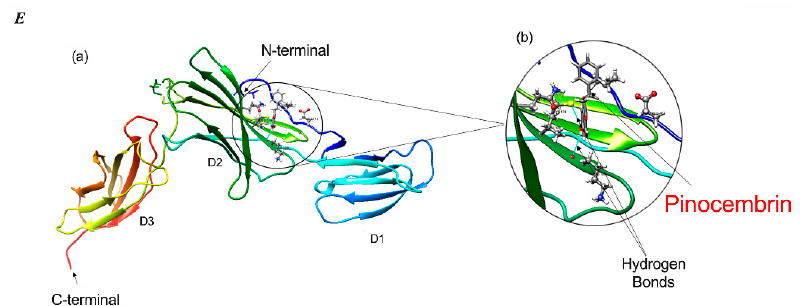
Figure 7. Molecular docking of flavonoid compounds with IL-6R α protein. Conformational changes of IL-6R α (PDB ID: 1N26) upon binding with luteolin, quercetin, chrysin, pinocembrin, and galangin ( A – E ), respectively. For all figures, sub-figures ( a ) illustrate the docked conformations of flavonoid with each of the interacting amino-acid residues of IL-6R α protein; Sub-figures ( b ) show enlarged views of the docked conformation of each flavonoid with the residues of IL-6R α . The β -sheet arrangement and helices (shades of blue, green, and orange for domains D1, D2, and D3, respectively) are shown. The blue lines indicate hydrogen bond formation of flavonoids with surrounding amino-acid residues. Table 1. Docking characteristics between the major MH flavonoids and IL-6R α protein, highlighting the hydrogen bonds formed between each flavonoid and the residues of IL-6R α . Estimated Flavonoid Cluster ∆ G (kcal/mol)